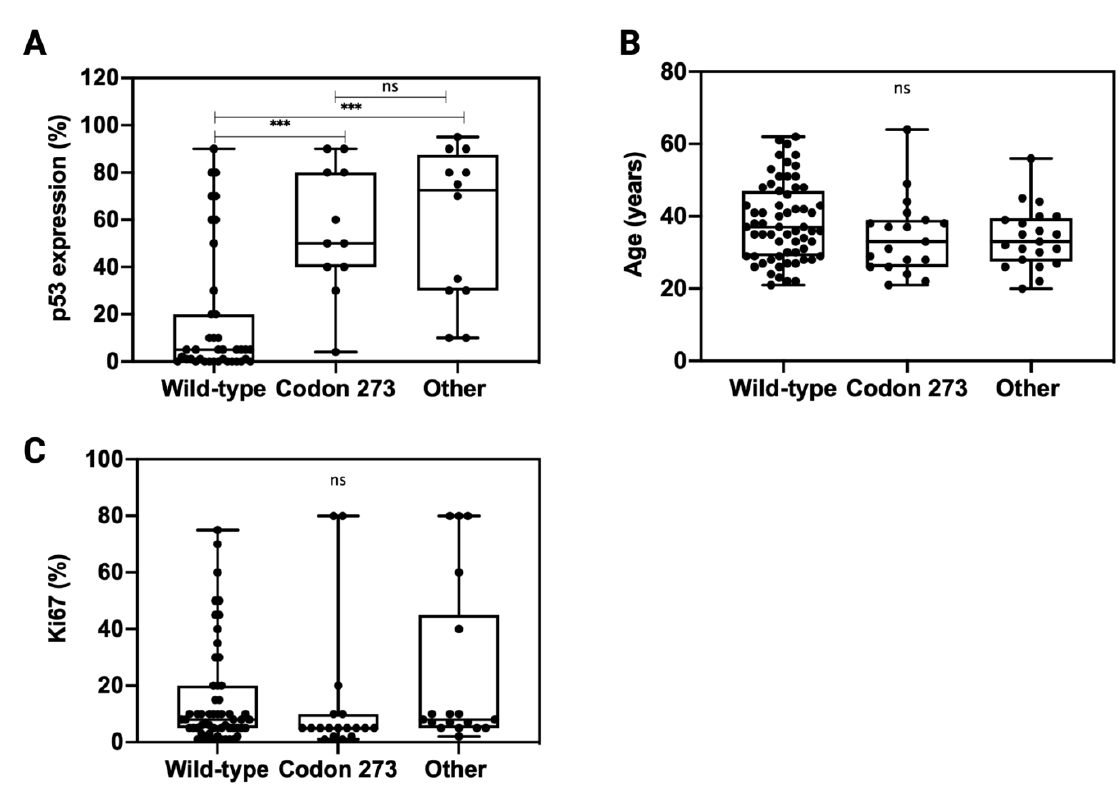
Figure 5. Distribution of p53 expression ( A ), patient age ( B ) and Ki67 ( C ) across TP53 mutation types: codon 273 mutant, wild-type and other TP53 mutations. Unpaired t -test was used for statistical analysis. *** p < 0.001, ns: not significant.